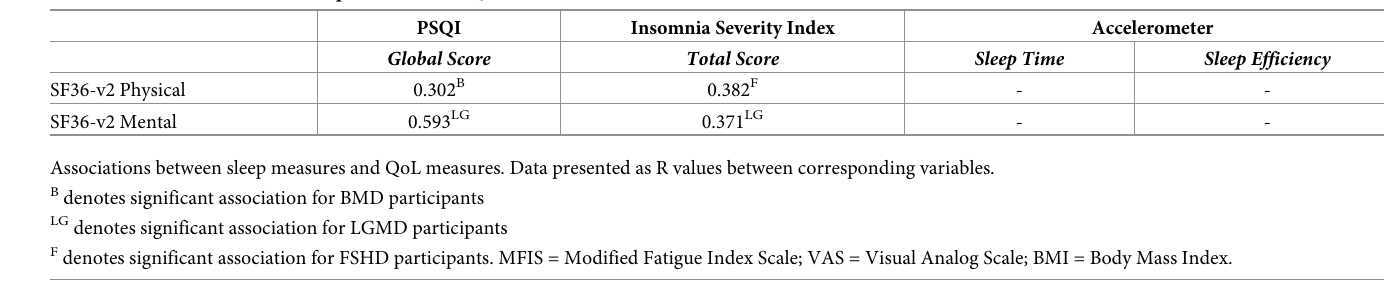
Table 4. Associations between sleep measures and